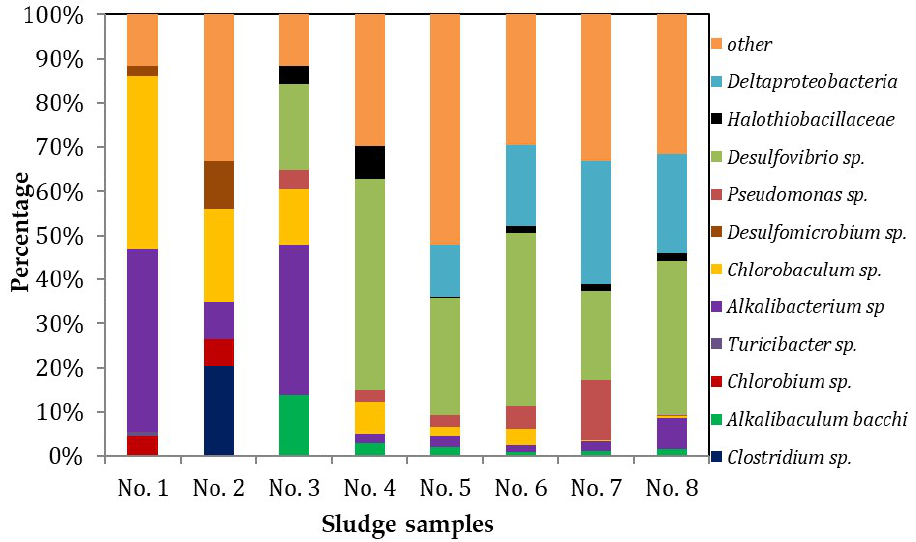
Figure 6 . Microbial population relative concentrations during the study. 188 Figure 6. Microbial population relative concentrations during the